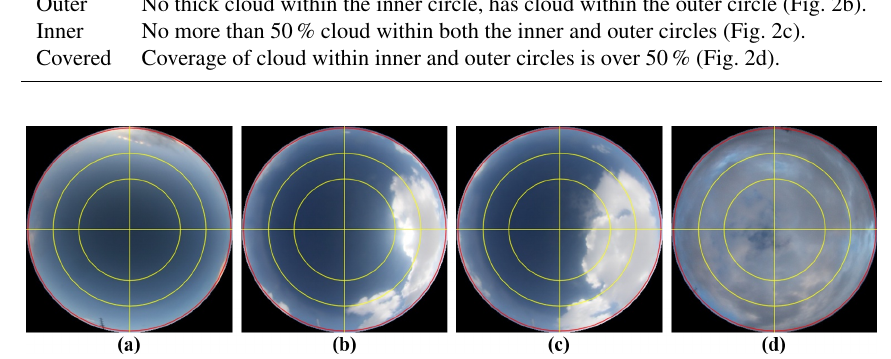
Figure 2. ASC image samples from dataset. (a) Clear, (b) outer, (c) inner and (d) covered.